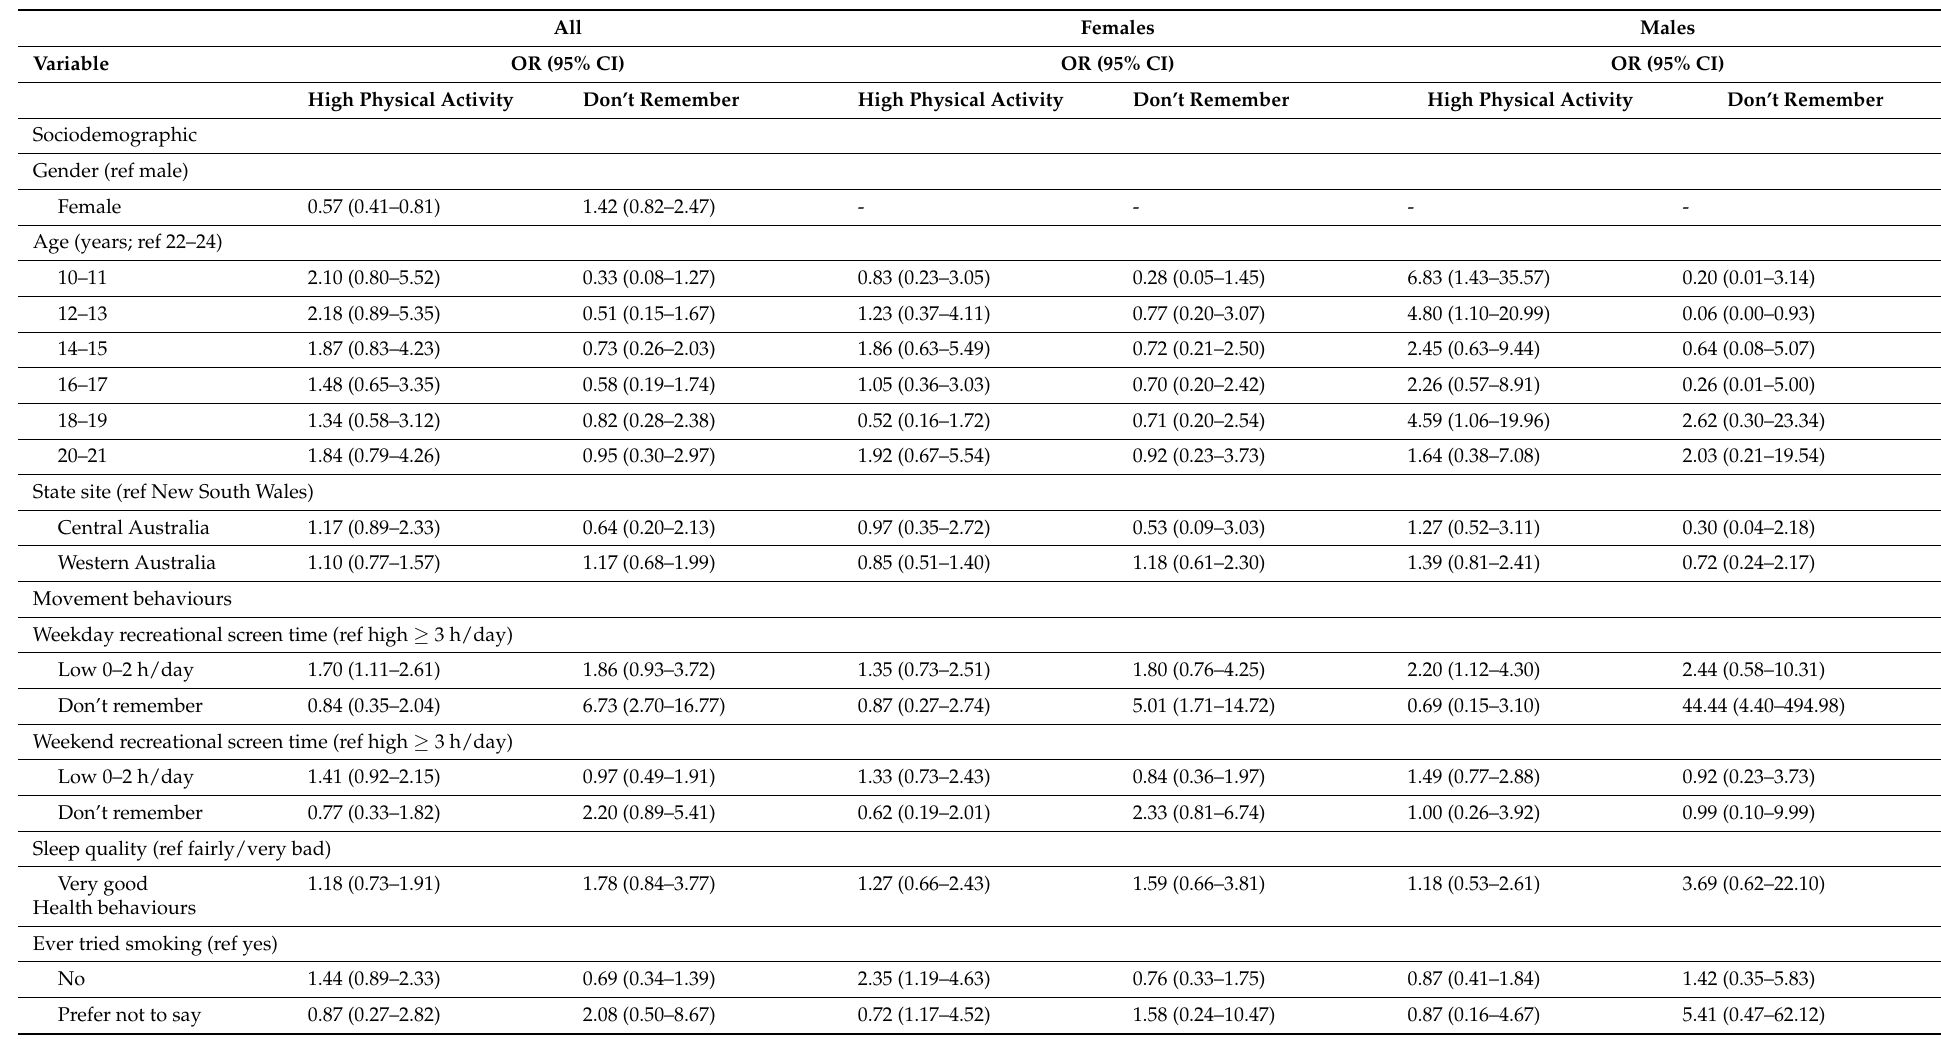
Table 2. Adjusted odds ratios (OR), and their 95% confidence intervals (95% CI) of NextGen participants achieving high physical activity ( ≥ 3 days: reference low physical activity 0–2 days), adjusted for sociodemographic, movement and health variables, among the whole sample and stratified by